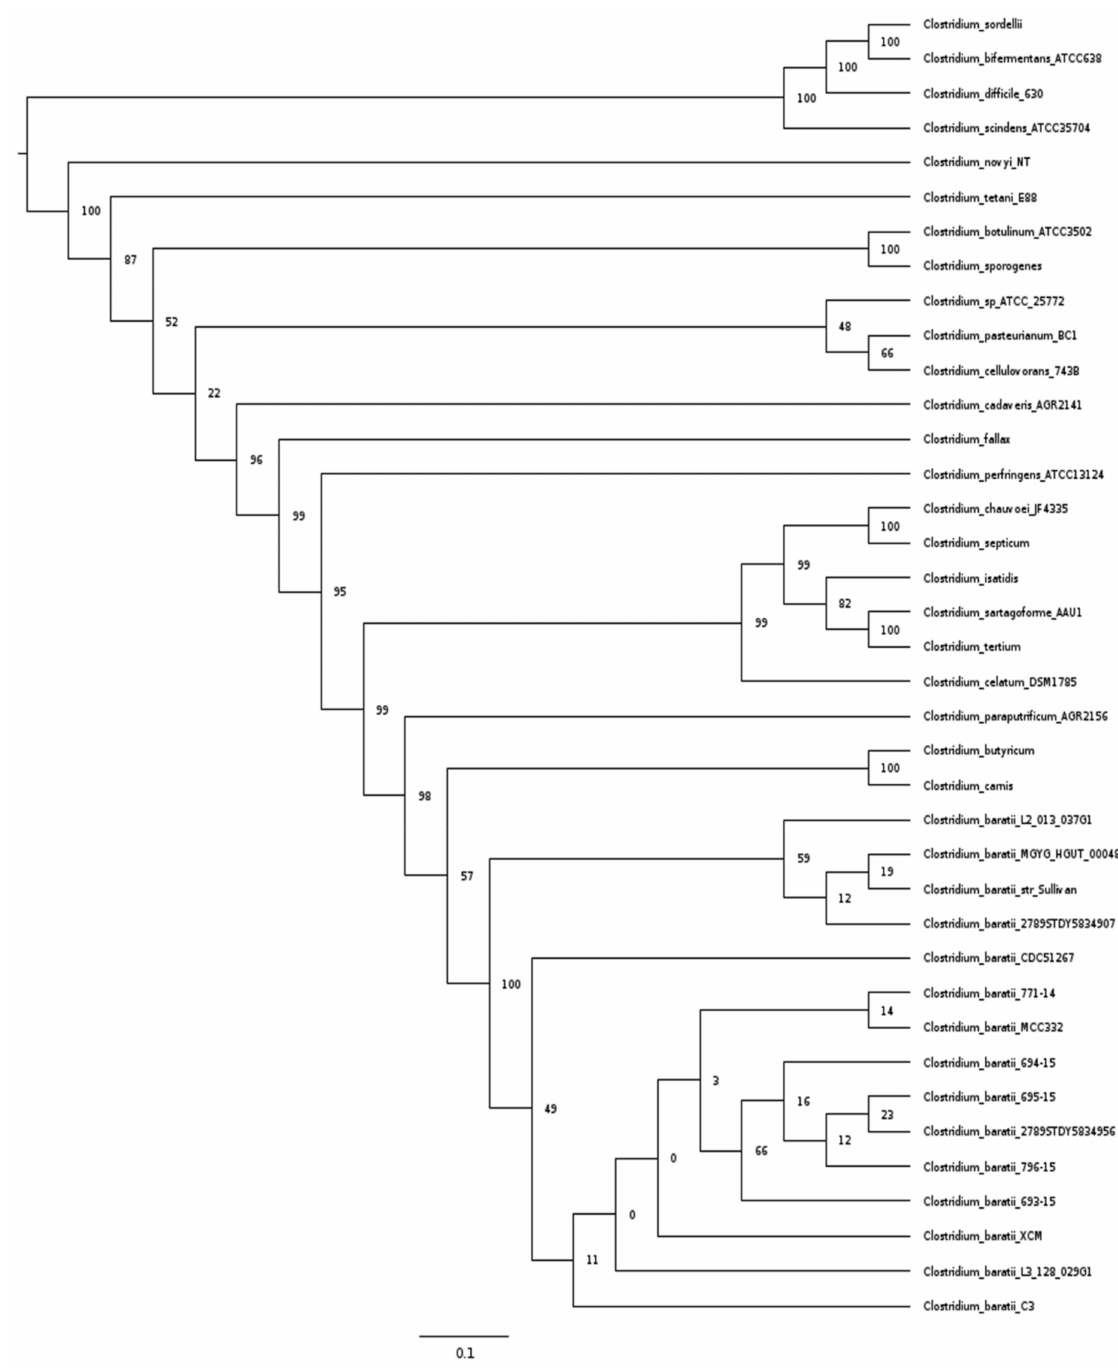
Figure 1. MLSA analysis of pathogenic Clostridium strains. Maximum Likelihood phylogenetic tree of pathogenic Clostridium strain based on 15 ribosomal protein data